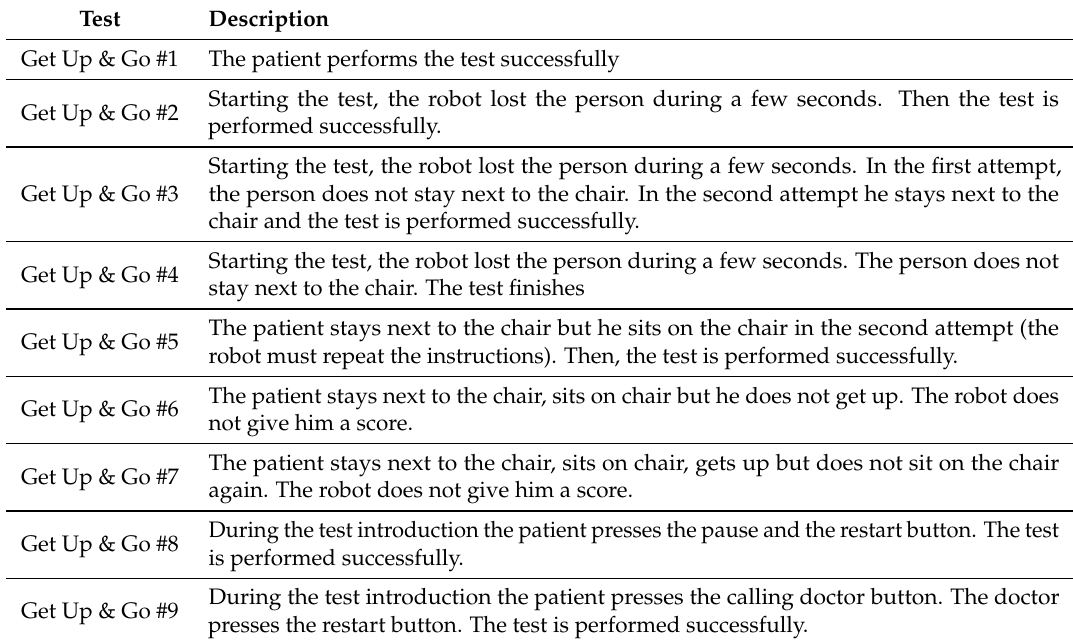
Table 5. Get Up & Go tests used to validate our model.